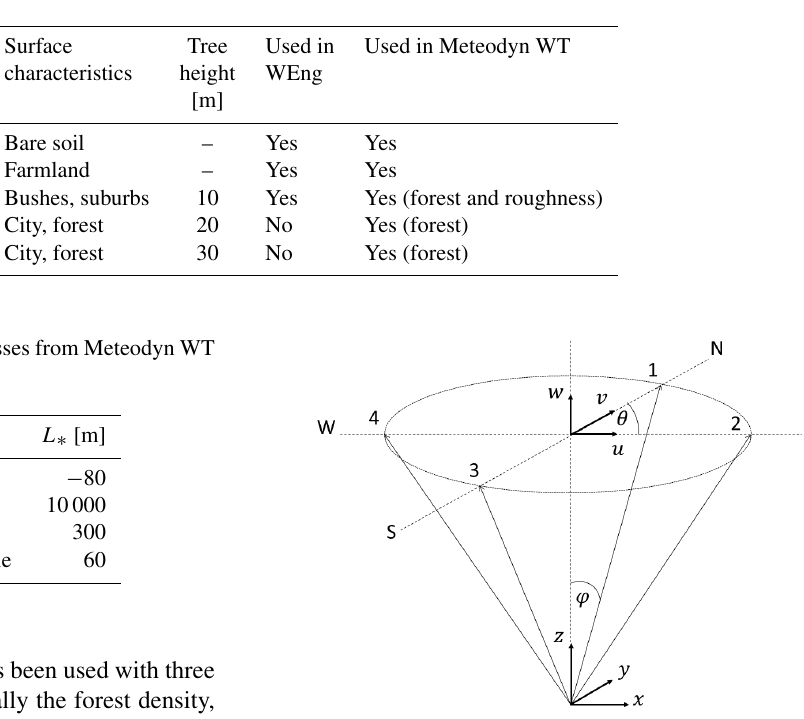
Table 2. Roughness lengths z 0 of the different roughness maps that were used in the flow models. The purpose of the maps is also given, which includes the corresponding tree heights in Meteodyn WT. Surface characteristics were taken from Troen (1989).